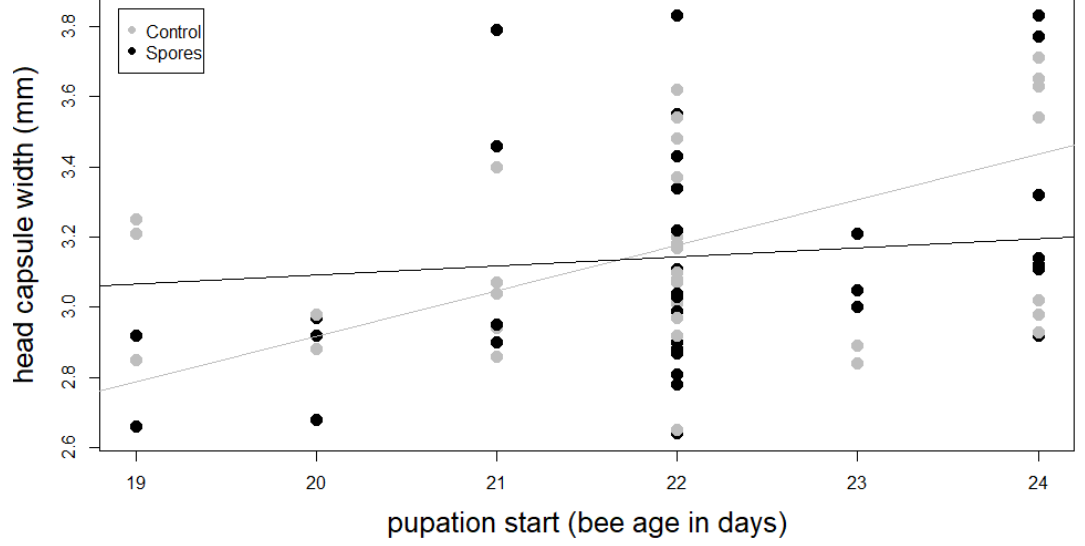
Figure 3. Interaction between head capsule width and pupation start of main treatment groups ‘Control’ and ‘Spores’.